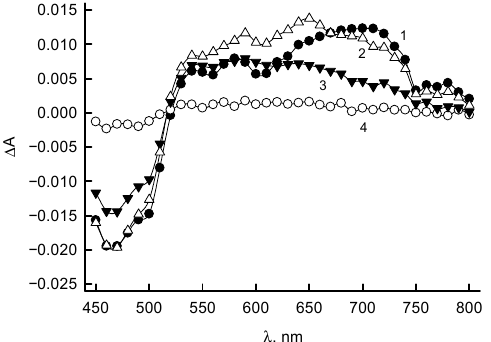
Figure 7. Spectra of reaction intermediates formed during the turnover of Rp FNR. Difference in absorbance is shown at several timepoints over the 450–800 nm wavelength range. Concentrations of Rp FNR, 4.0 µM; NADPH, 50 µM; and duroquinone, 250 µM (after mixing). Spectra correspond to absorbance changes at 100 ms (1), 1 s (2), 5 s (3), and 20 s (4).